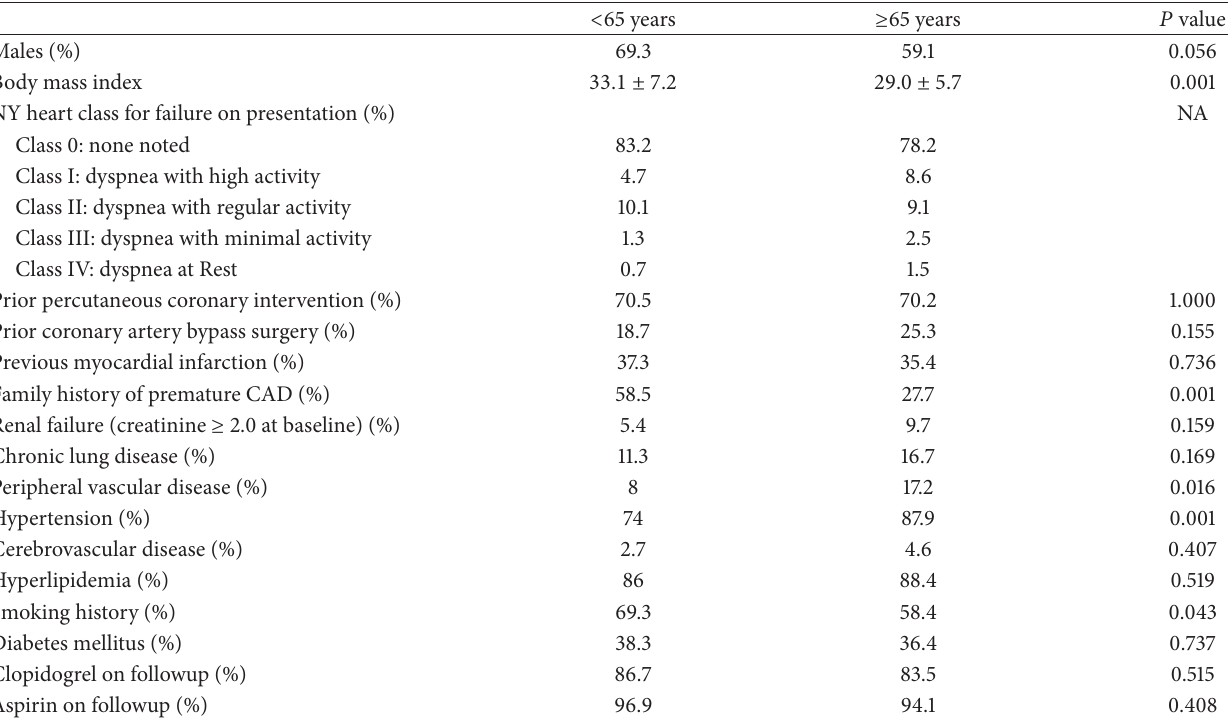
Table 1: Demographic and clinical variables.